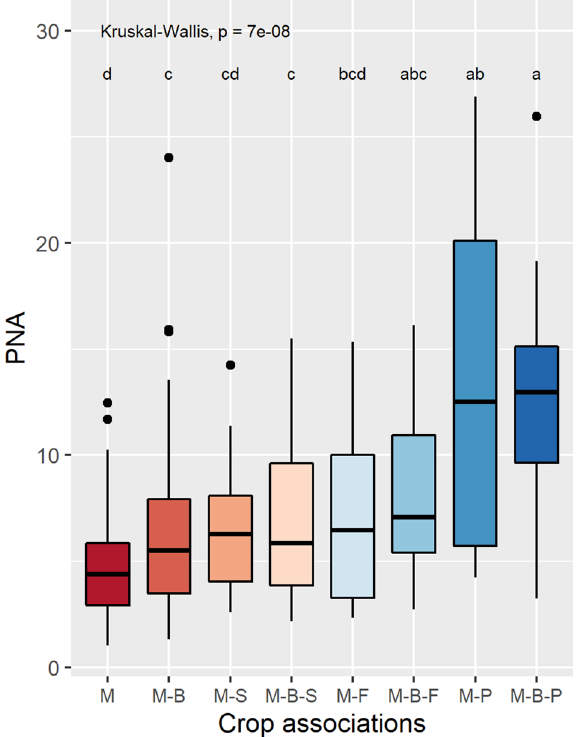
Figure 6. The Potential Nutrient Adequacy (PNA) of milpa systems in the Western Highlands of Guatemala. Crop combinations are ordered by their PNA mean value. Dunn’s test significant groups are indicated by letters within the graph. Crop associations codes are: M: Maize monocrop, M-B: Maize-Bean, M-S: Maize-Squash, M-B-S: Maize-Bean-Squash, M-F: Maize-Faba, M-B-F: Maize-Bean-Faba, M-P: Maize-Potato, M-B-P: Maize-